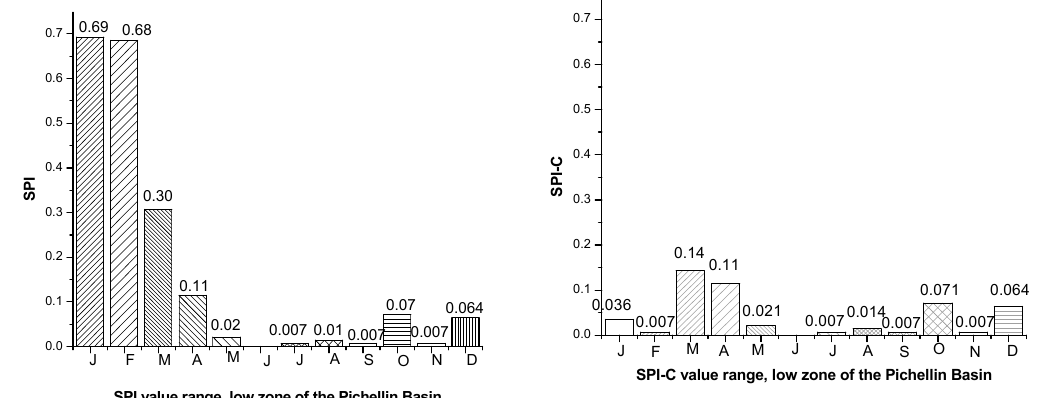
Figure 16. Comparative SPI and SPI-C, low zone of the basin.